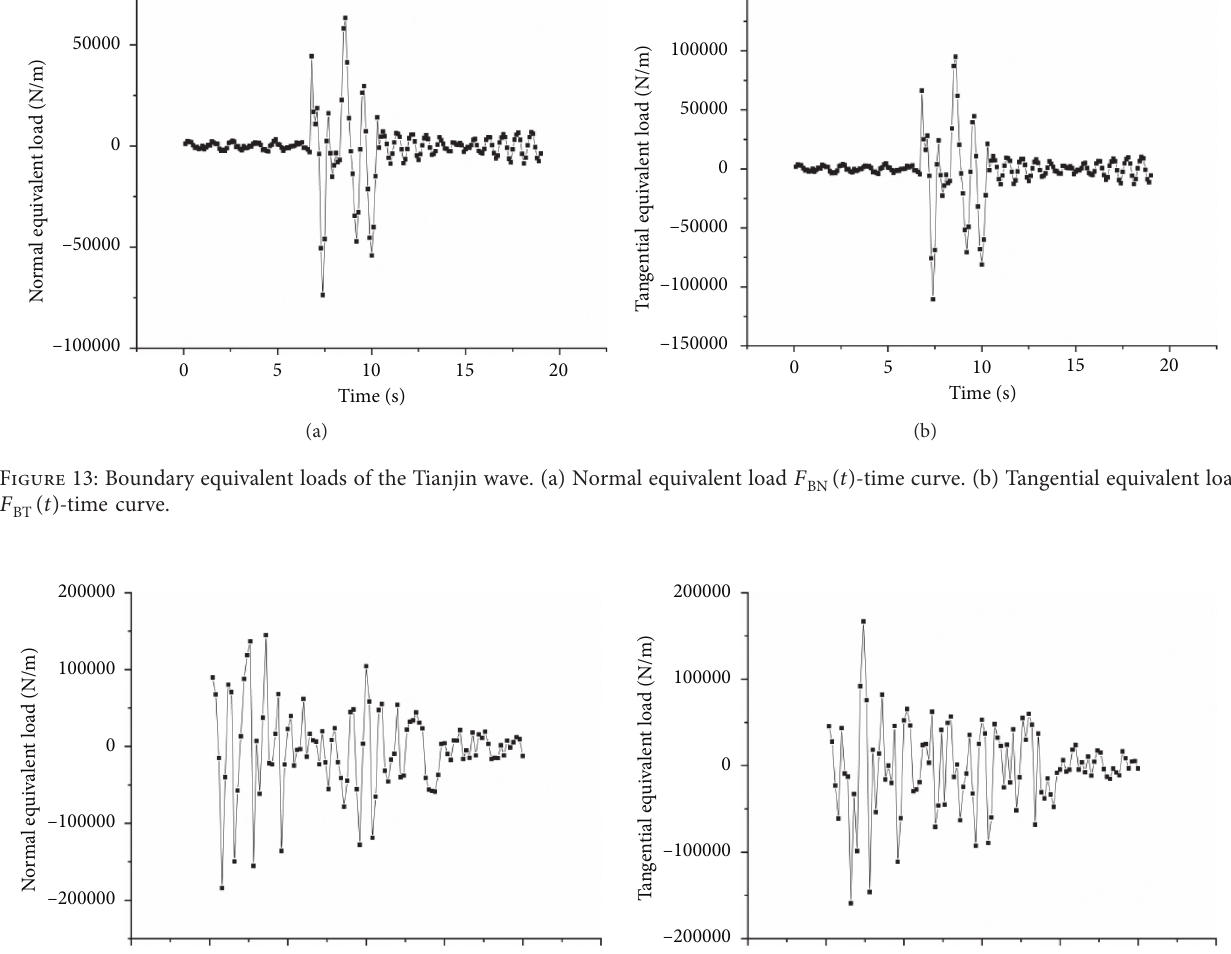
( t ) - time curve. (b) Tangential equivalent load BN